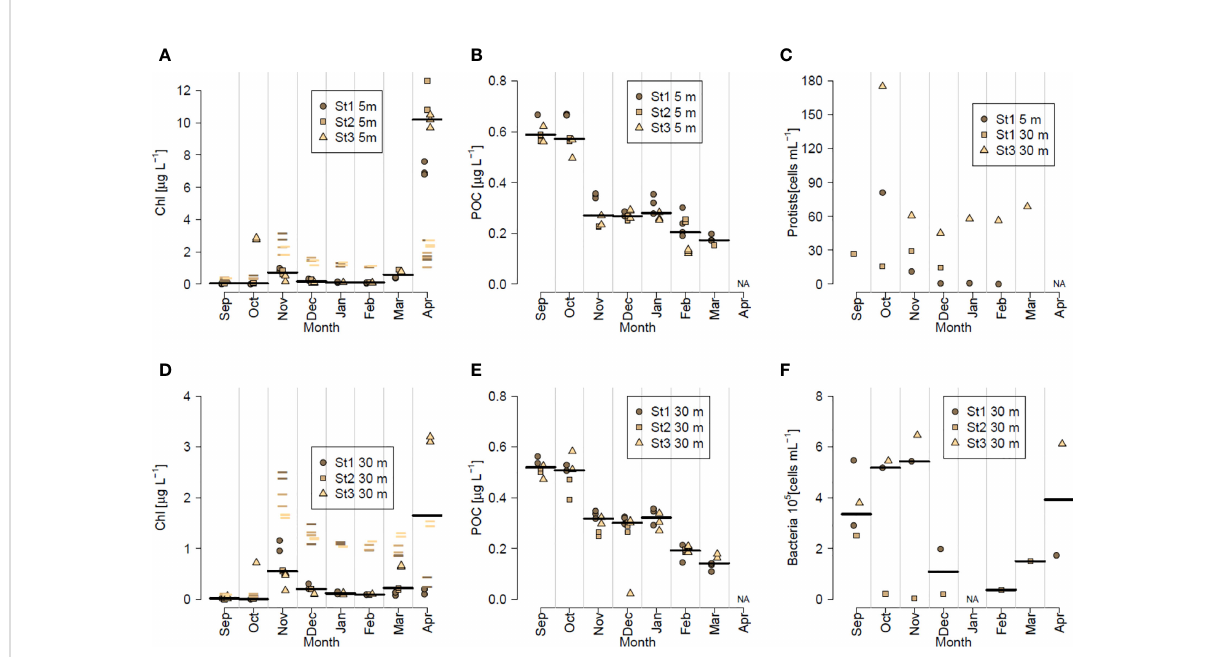
FIGURE 5 Biomass indicators for phytoplankton (Chlorophyll a (Chl); A, D and Phaeophytin a, as -), particulate organic matter (POC; B, E ), bacteria (abundance, F ), and protists abundance (C) . Plots a-b show data at 5 m depth. Plot C data at 5 m and 30 m depth, and plots (D – F) data at 30 m depth. Note the different scales used for a and d. Horizontal black lines represent the median of all data (excluding Phaeophytin a) of the month, and different symbols show the individual data for the three stations. Missing data for April are marked with